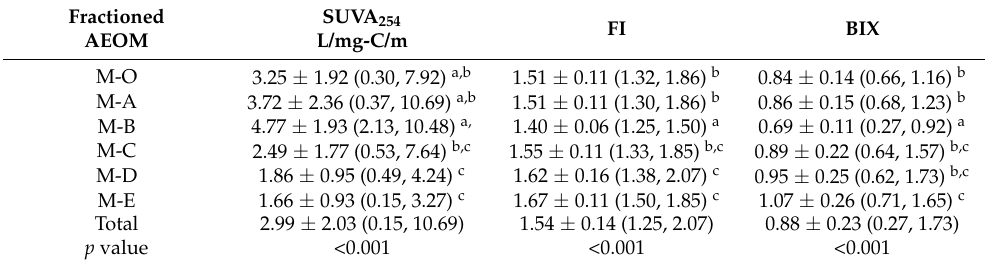
Table 1. The optical values of SUVA 254 , BIX, and FI for bulk and size-fractioned AEOM